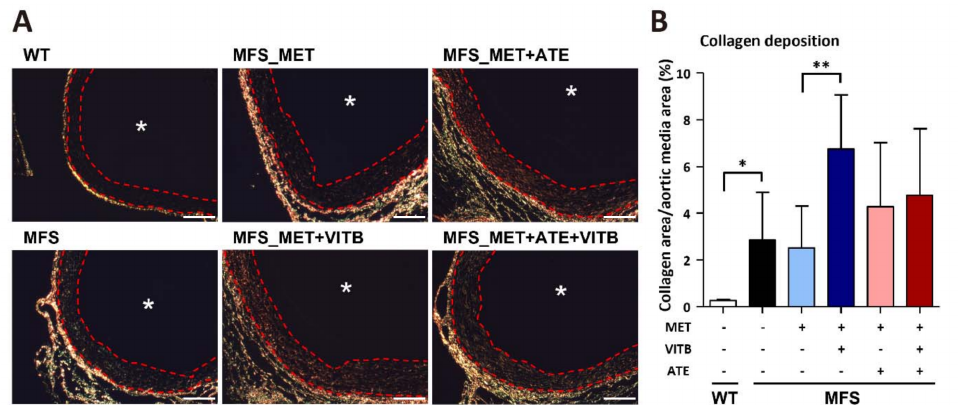
Figure 4. VITB increased collagen deposition in ascending aortic aneurysm of MFS mice. ( A ) Representative Picro-Sirius stain section of ascending aorta under polarized light. Collagen fibers present birefringence under polarized light. Red dashed line indicates aortic media boundary. Asterisk indicates aorta luminal side. Scale bar, 100 µ m. ( B ) Quantification of collagen deposition in WT and MFS mice with different regiments ( n = 3–6 per group). Data are presented as the mean ± SD. * p < 0.05, ** p <